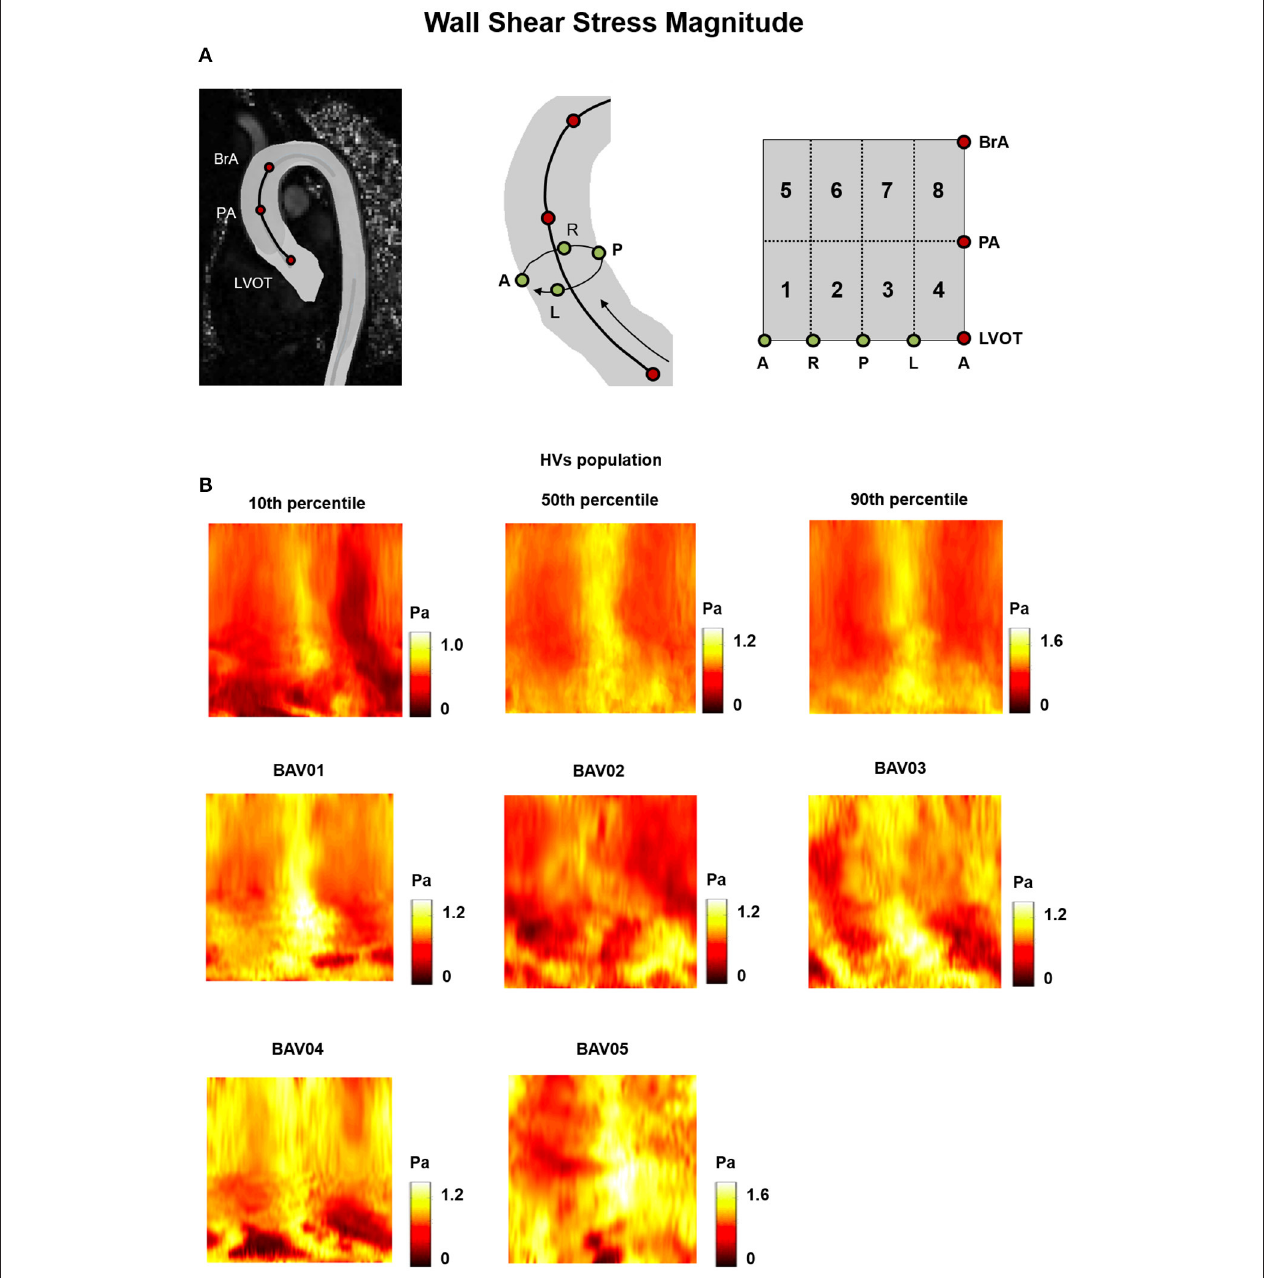
FIGURE 5 | (A) The 2D template detailed in Figure 3 is reported for the sake of clarity. (B) Wall Shear Stress (WSS) heat maps for HVs (represented as 10th, 50th, and 90th percentiles) and for each BAV patient obtained at peak systole.